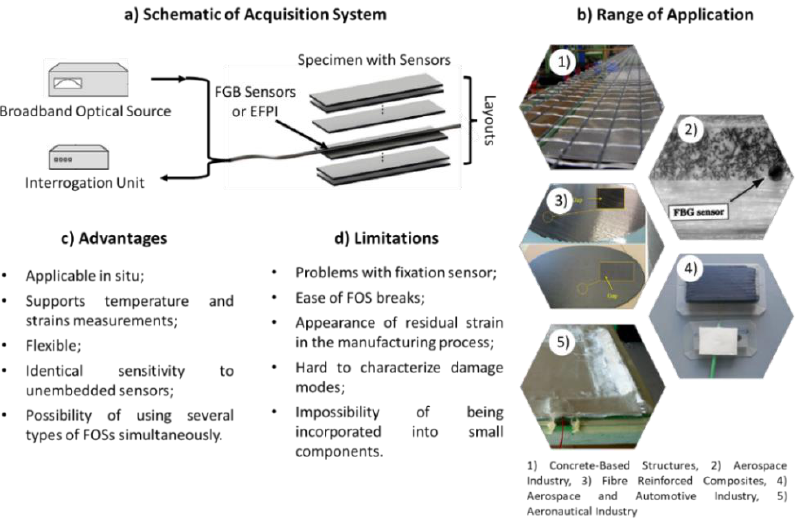
Figure 4. Fibre optic sensors embedded in composite components.